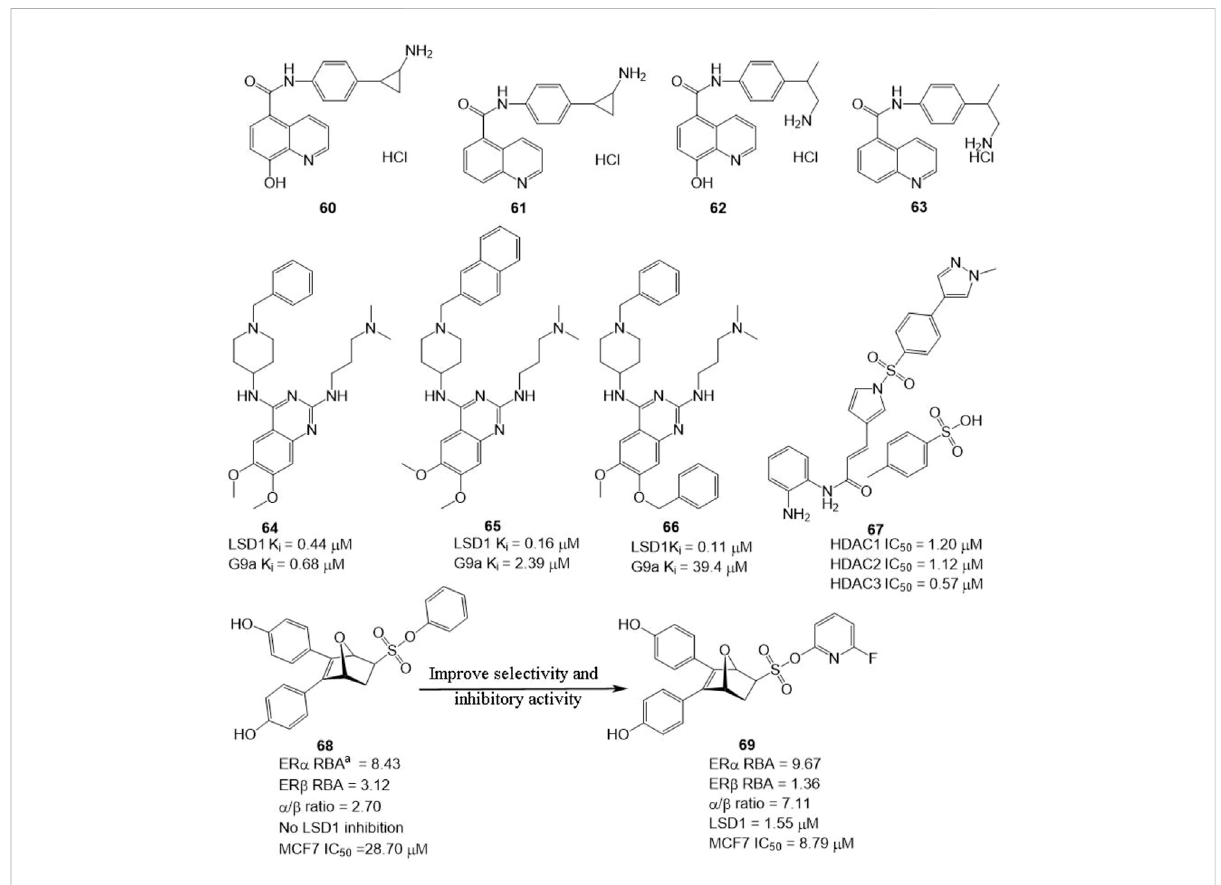
FIGURE 10 Structure of reported dual-target inhibitors. a RBA values = IC E2 50 /IC Compound 50 × 100 ± the range (RBA value of E2 as